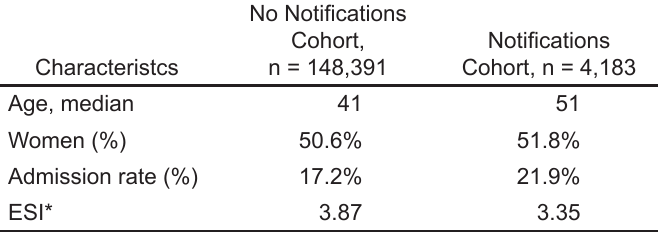
Table 1. Characteristics of the no push notification and push notification